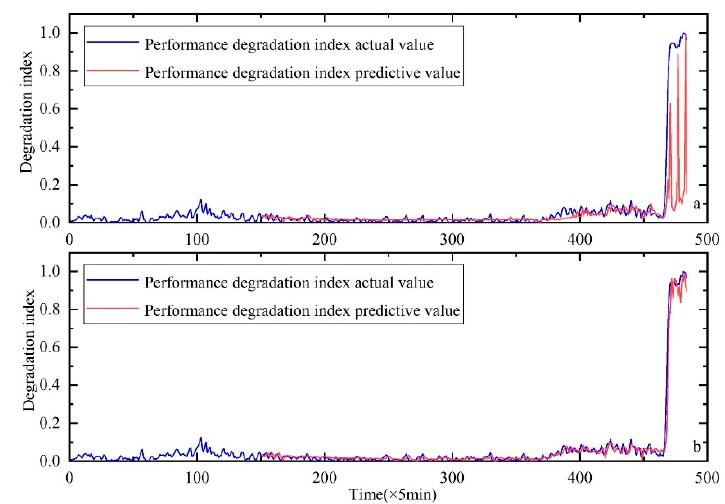
Figure 18. Performance degradation prediction of the rolling bearings, ( a ) is the result of HKF–SVR with parameters optimized by the GA and ( b ) is the result of HKF–SVR with parameters optimized by the KH.